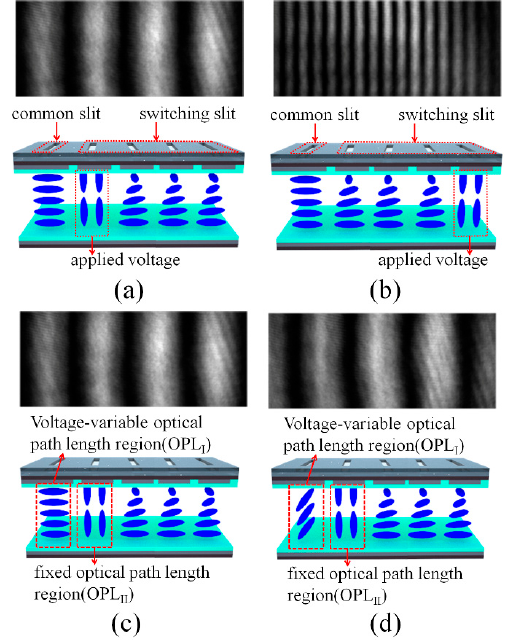
Figure 2. Operation principles of the DFPG switched by field-induced patterned LC orientations and the resulting projected fringe patterns. ( a , b ) show the LC orientations and spatial frequency variations of the projected fringe patterns by control of the selected switching slit with applied voltages: ( a ) Δ g = 200 µm slit spacing and ( b ) Δ g = 800 µm slit spacing; ( c , d ) show the field-induced LC orientations and the moving fringe patterns by control of the phase shifting at the common slit with applied voltages under the fixed slit spacing condition ( Δ g = 200 µm slit spacing).